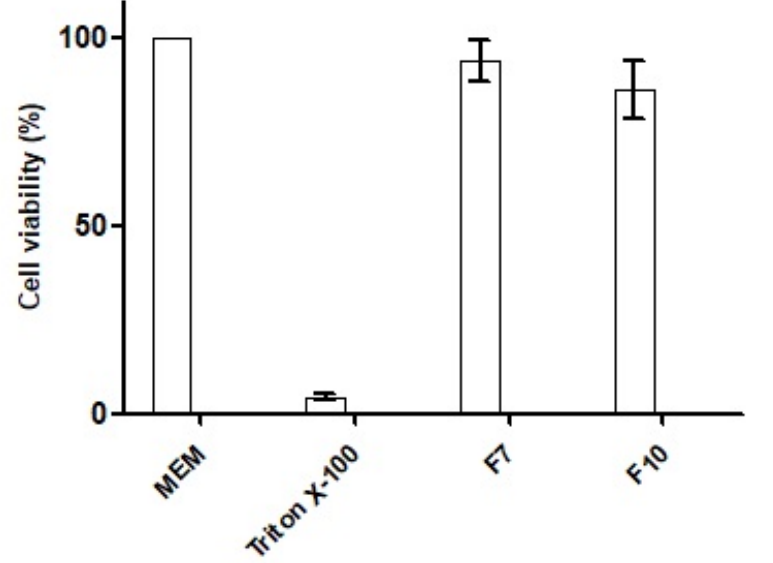
Figure 9. Viability percentage of HCT-116 cells after 4 h of exposure to 0.5% nanoemulsions with OC (F7) and OC-PAP (F10). MEM alone served as negative control, whereas, 1% triton X-100 solution in MEM was taken as positive control. The values are described as means of three experiments ± standard deviation.